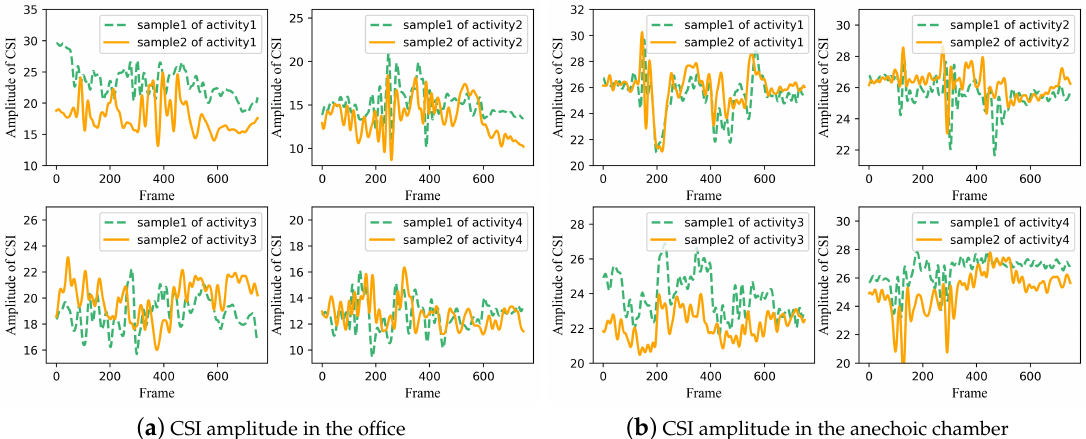
Figure 4. CSI amplitude of four different activities at the same location in two experimental scenes. ( a ) CSI amplitude in the office. ( b ) CSI amplitude in the anechoic chamber. Two curves in each subgraph are two samples for the same activity. The horizontal axis of each subgraph represents the frame, the ordinate of each subgraph indicates amplitude of